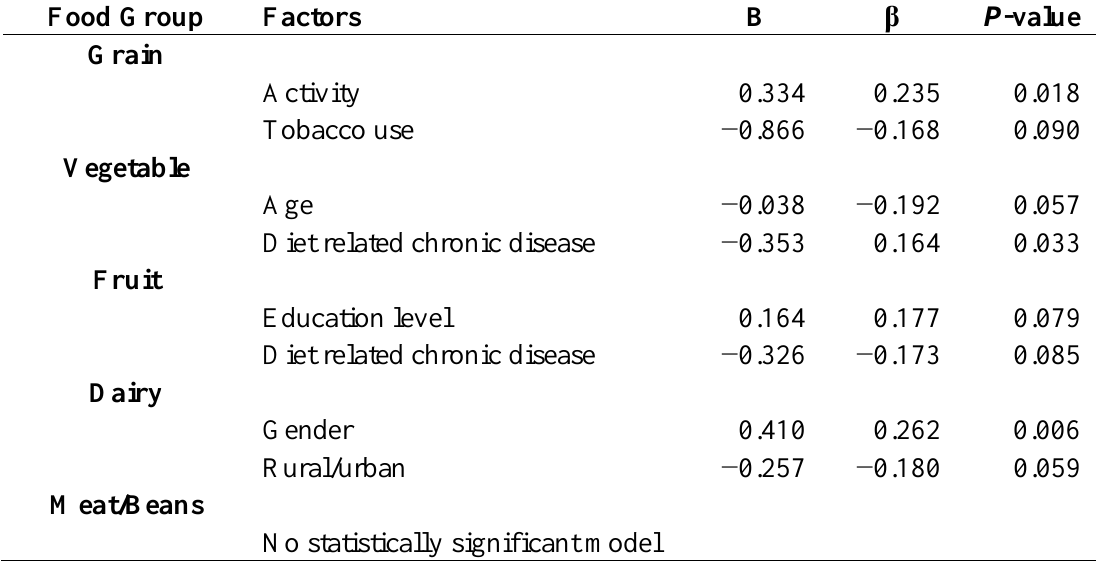
Table 4. Demographic and health factors predicting food group